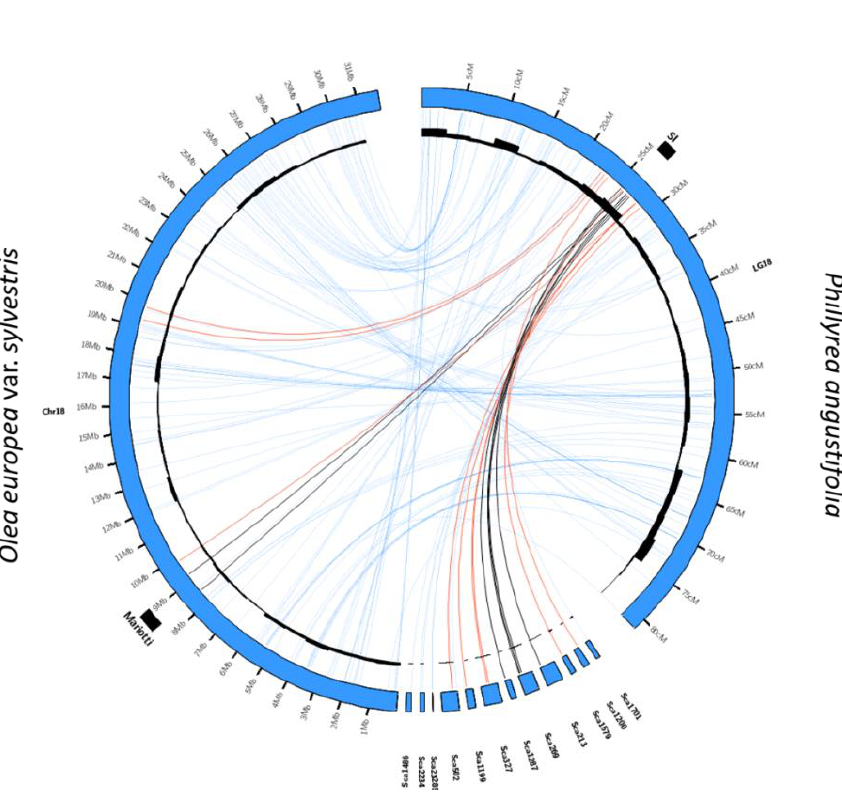
Figure 5 . Synteny plot between the P. angustifolia linkage group 18 (scale in cM) and the olive tree chromosomes 18 and a series of unanchored scaffolds (scale in Mb). Lines connect markers in the P. angustifolia linkage map with their best BLAST hit in the O. europea genome. Blue lines correspond to markers with autosomal inheritance. Black lines correspond to markers which strictly cosegregate with SI phenotypes (Ha vs. Hb). Red lines correspond to markers with strong but partial (95%) association with SI. The region found to be genetically associated with SI in the olive tree by Mariotti et al. (2020) is shown by a black rectangle. Variation of the density of loci in bins of 3.125cM along linkage groups and 1 Mbp along chromosomes is shown in the inner circle as a black